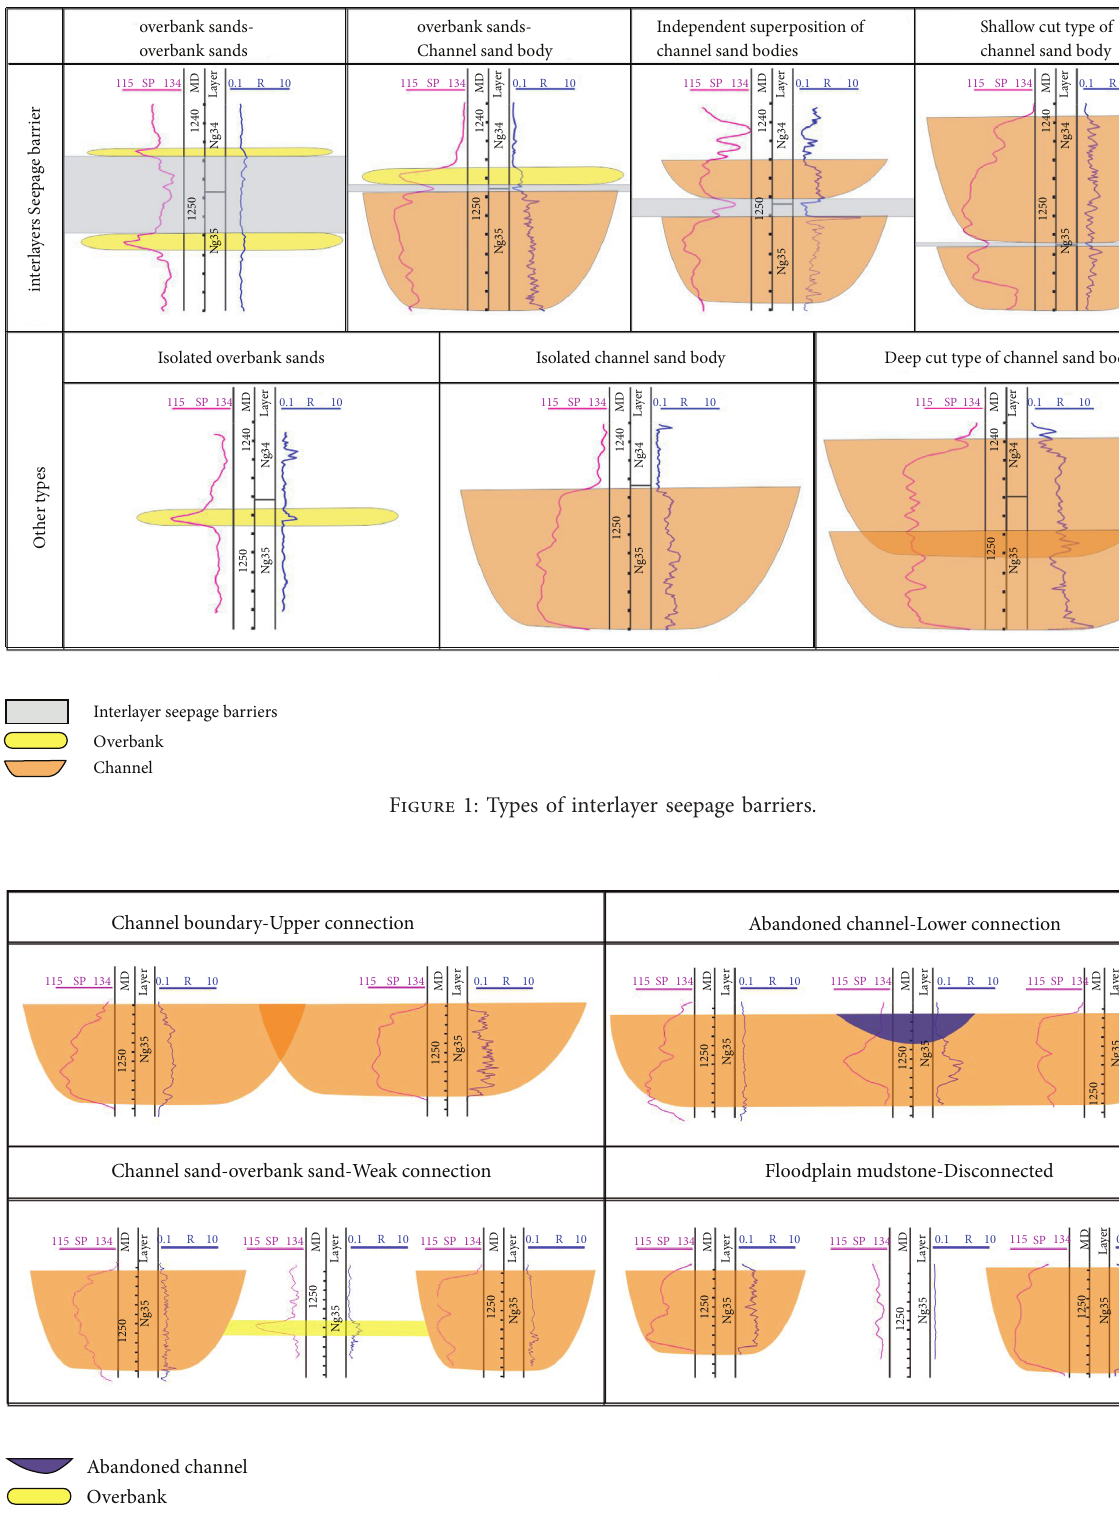
Figure 2: Types of planar seepage